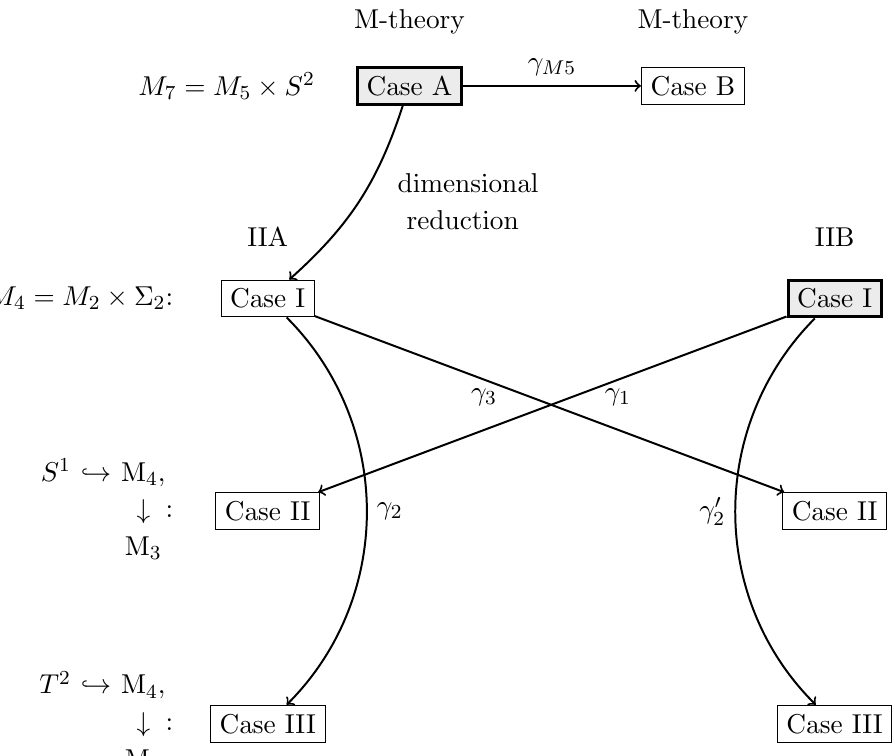
Figure 2 . Depiction of the chains of dualities leading to the various Mink 4 (cid:2) S 2 class in type II with equal spinor norm. Cases A in M-theory and I in IIB (shaded grey) are the truly